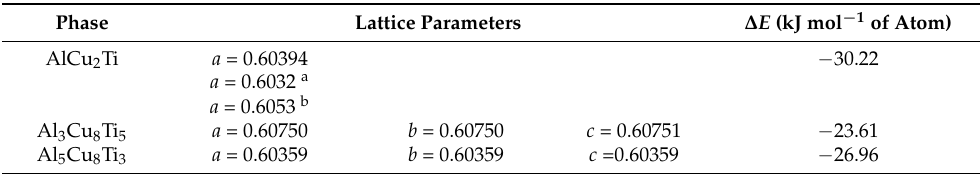
Table 10. The calculated elastic constants for the Al-Cu-Ti intermetallics. Phase